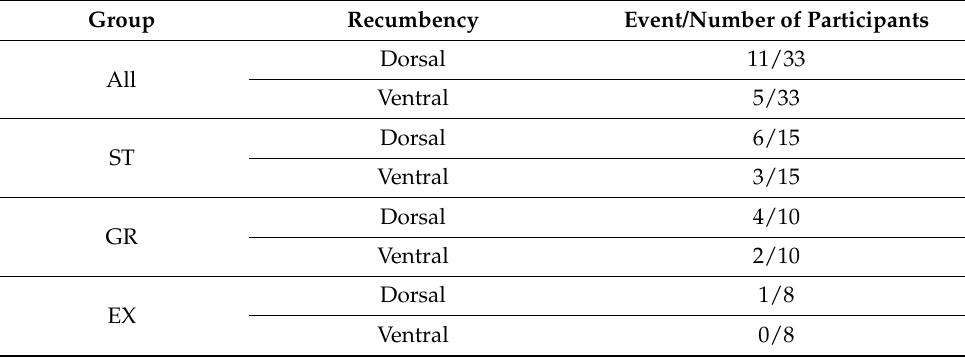
Table 2. Occurrence of soft palate entrapments. The subgroup analysis is also